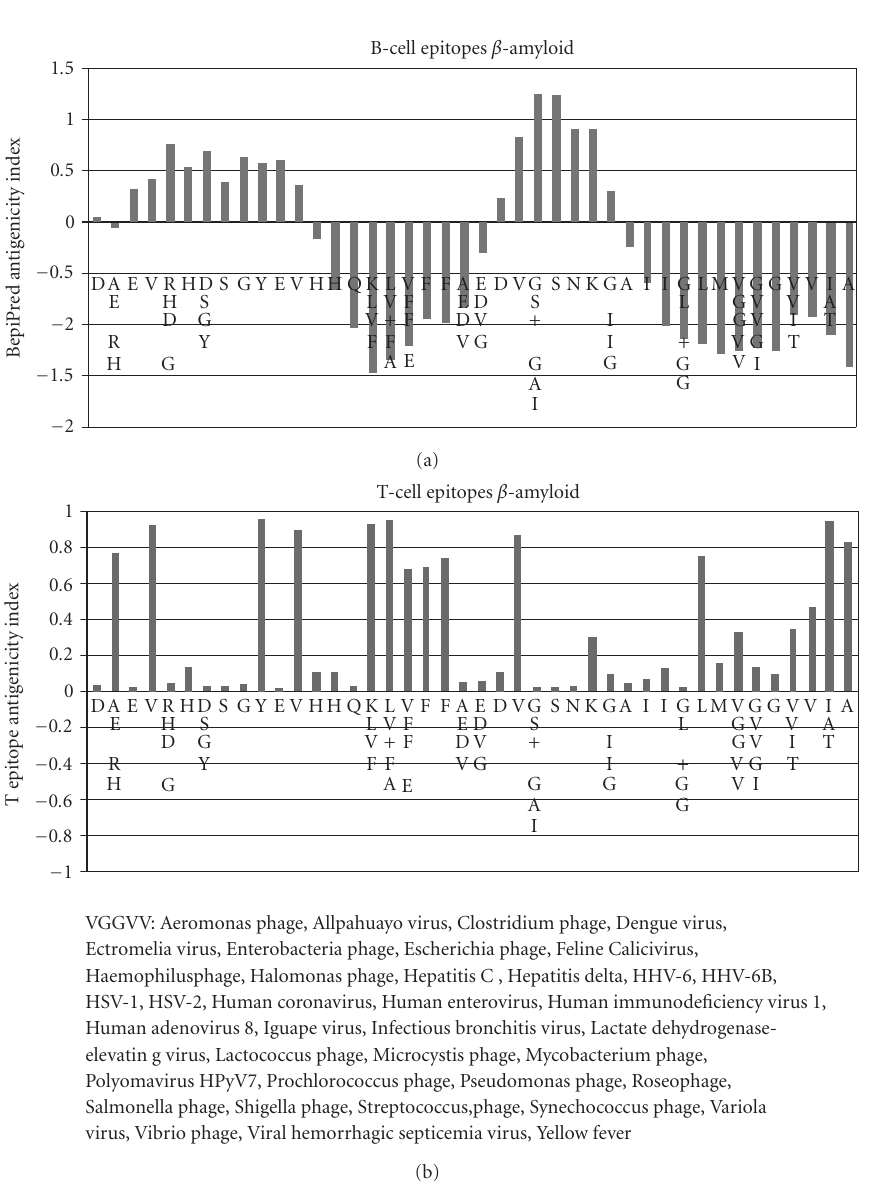
Figure 2: The B cell and T cell immunogenicity profile for the beta-amyloid peptide. According to the servers, antigenicity values of > 0.35 (B cell) or 0.5 (T cell) are considered immunogenic. The sequences of herpes simplex viral proteins that align with beta-amyloid are shown. Space: non-identical amino acid; +: conserved amino acid with similar physicochemical properties. Viruses and phages containing the VGGVV sequence, which has been used as an epitope to label beta-amyloid in Alzheimer’s disease, are also shown. performance [52]. However amyloid antibodies extracted from the serum of old APP transgenic mice potentiate the display an enhanced immune response to the peptide